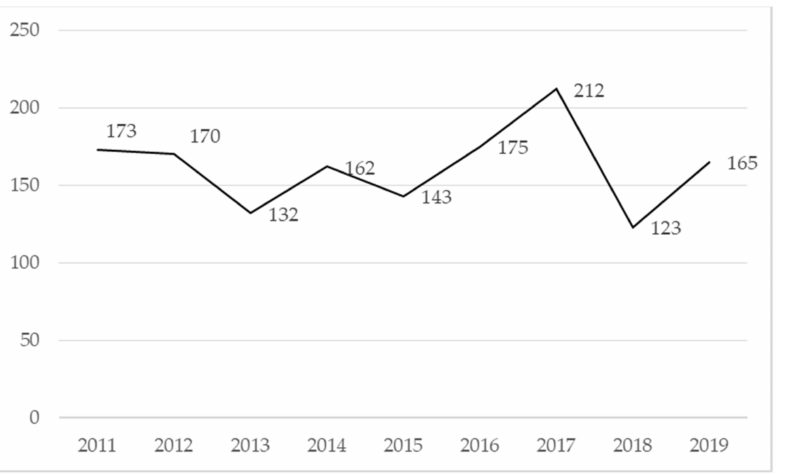
Figure 5. Yearly number of casualties due to fire or explosions in Spain based on the yearly reports of the Spanish Asociaci ó n Profesional de T é cnicos de Bomberos